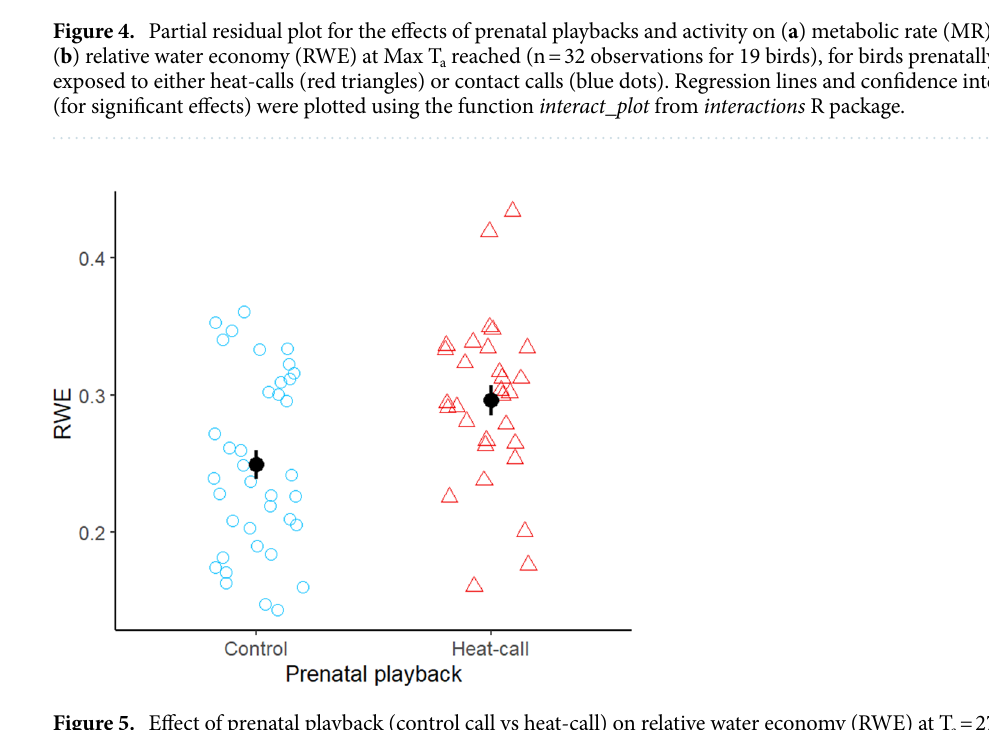
Figure 5. Effect of prenatal playback (control call vs heat-call) on relative water economy (RWE) at T a = 27 °C (n = 67 for 34 birds), for birds prenatally exposed to either contact calls (control, blue dots) or heat-calls (red triangles). Markers and error bars show mean ±